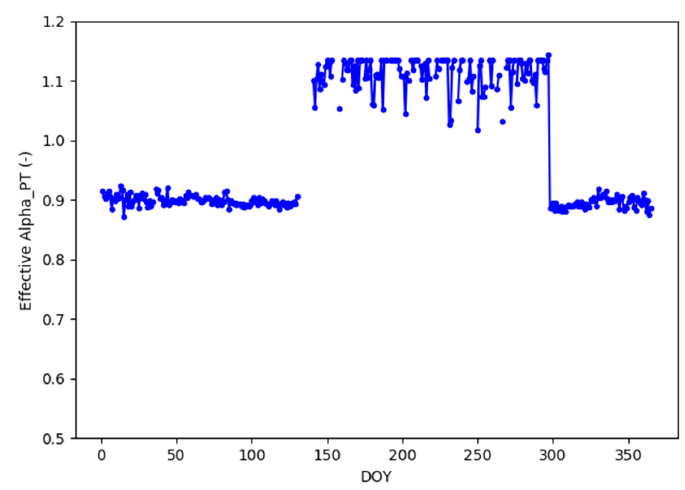
Figure A4. Time series of daily daytime average of retrieved effective 𝜶 𝑷𝑻 with TSEB ‐ 2S for 2015 at the CT.